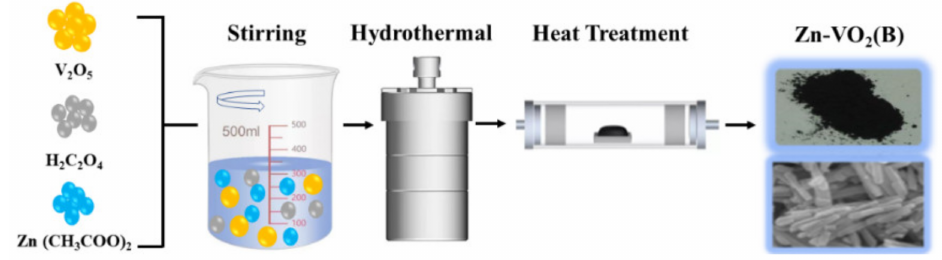
Figure 1. The schematic diagram of the preparation process of the Zn-VO 2